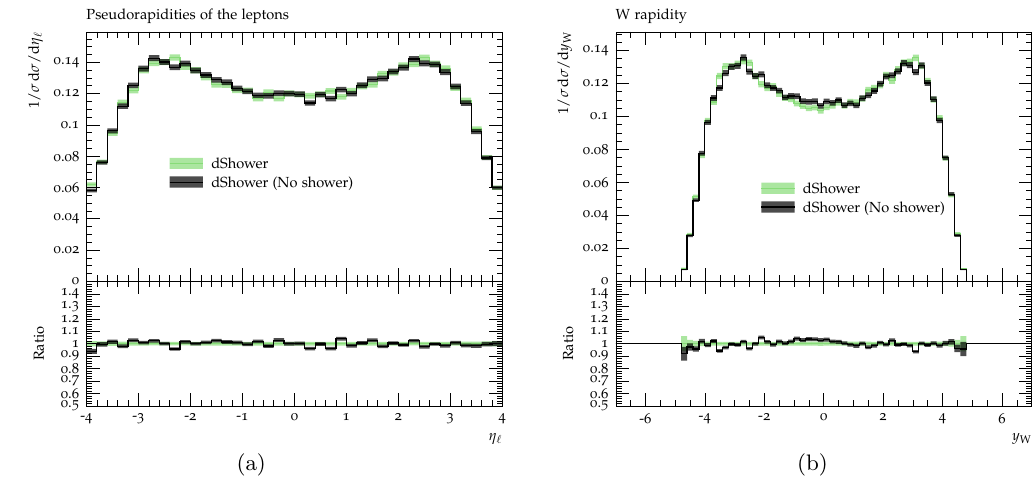
Figure 17 . (a) Pseudorapidities of the two charged leptons. (b) Rapidities of the two W bosons.